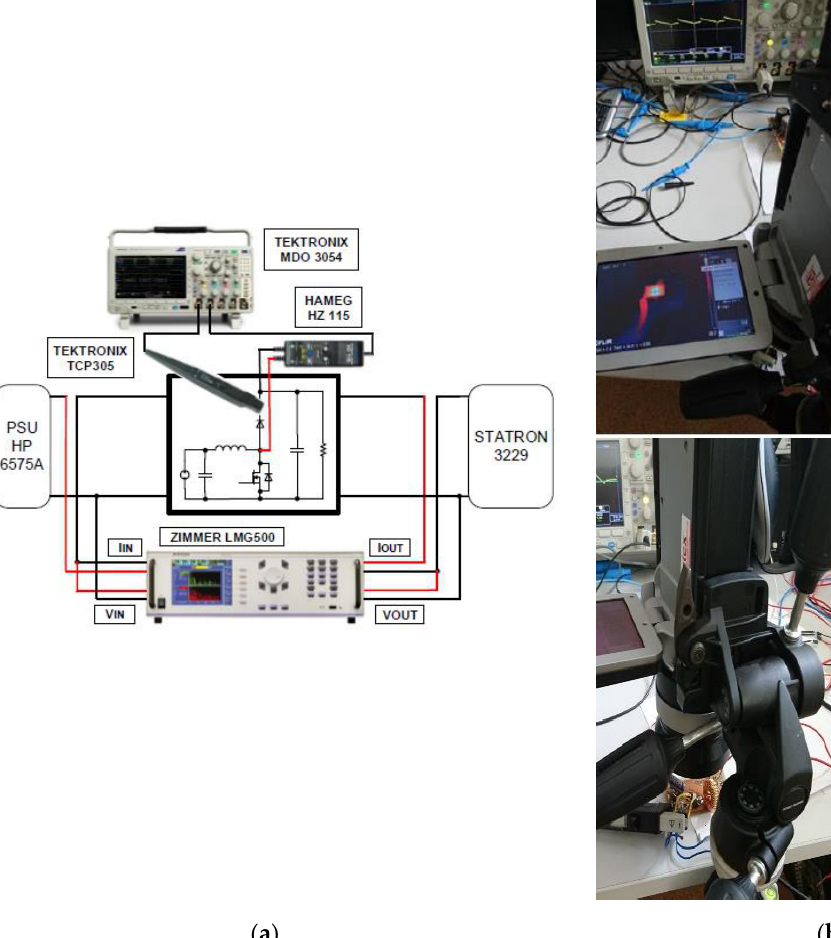
Figure 12. Measurement Situation: ( a ) block diagram; ( b ) photo from experimental measurements. Table 5. Operational Parameters of the Boost Converter During the Tests.